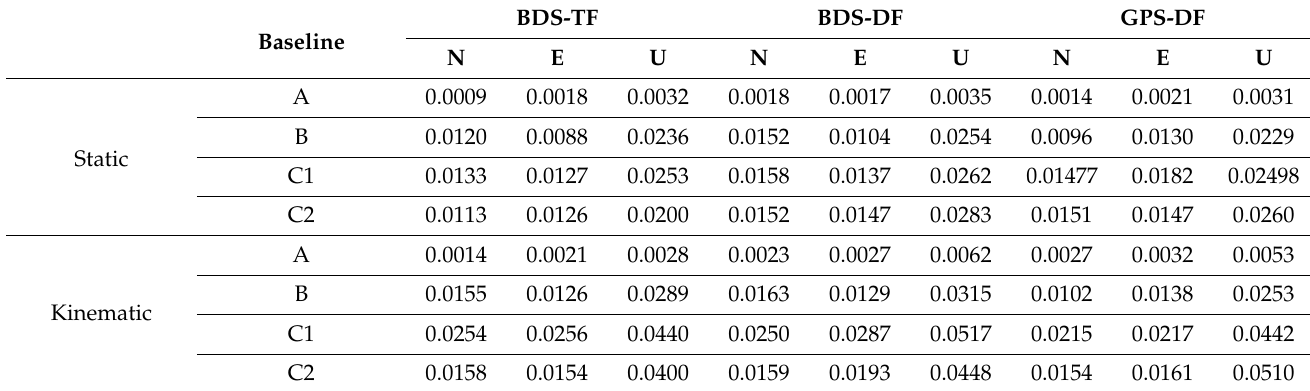
Table 6. The RMS of each baseline position in static model, unit is m.